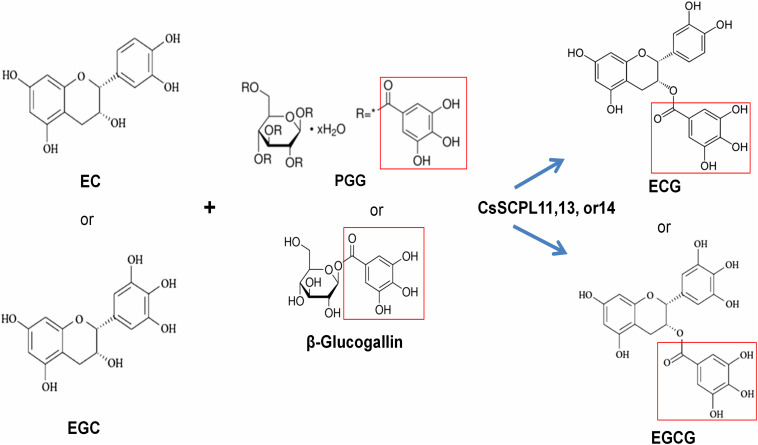
The proposed working model for CsSCPL11,13,14 recombinent proteins-catalyzed galloylation of EC and EGC by using 1,2,3,4,6-penta-O-galloyl-β-D-glucose (PGG) or β-glucogallin.